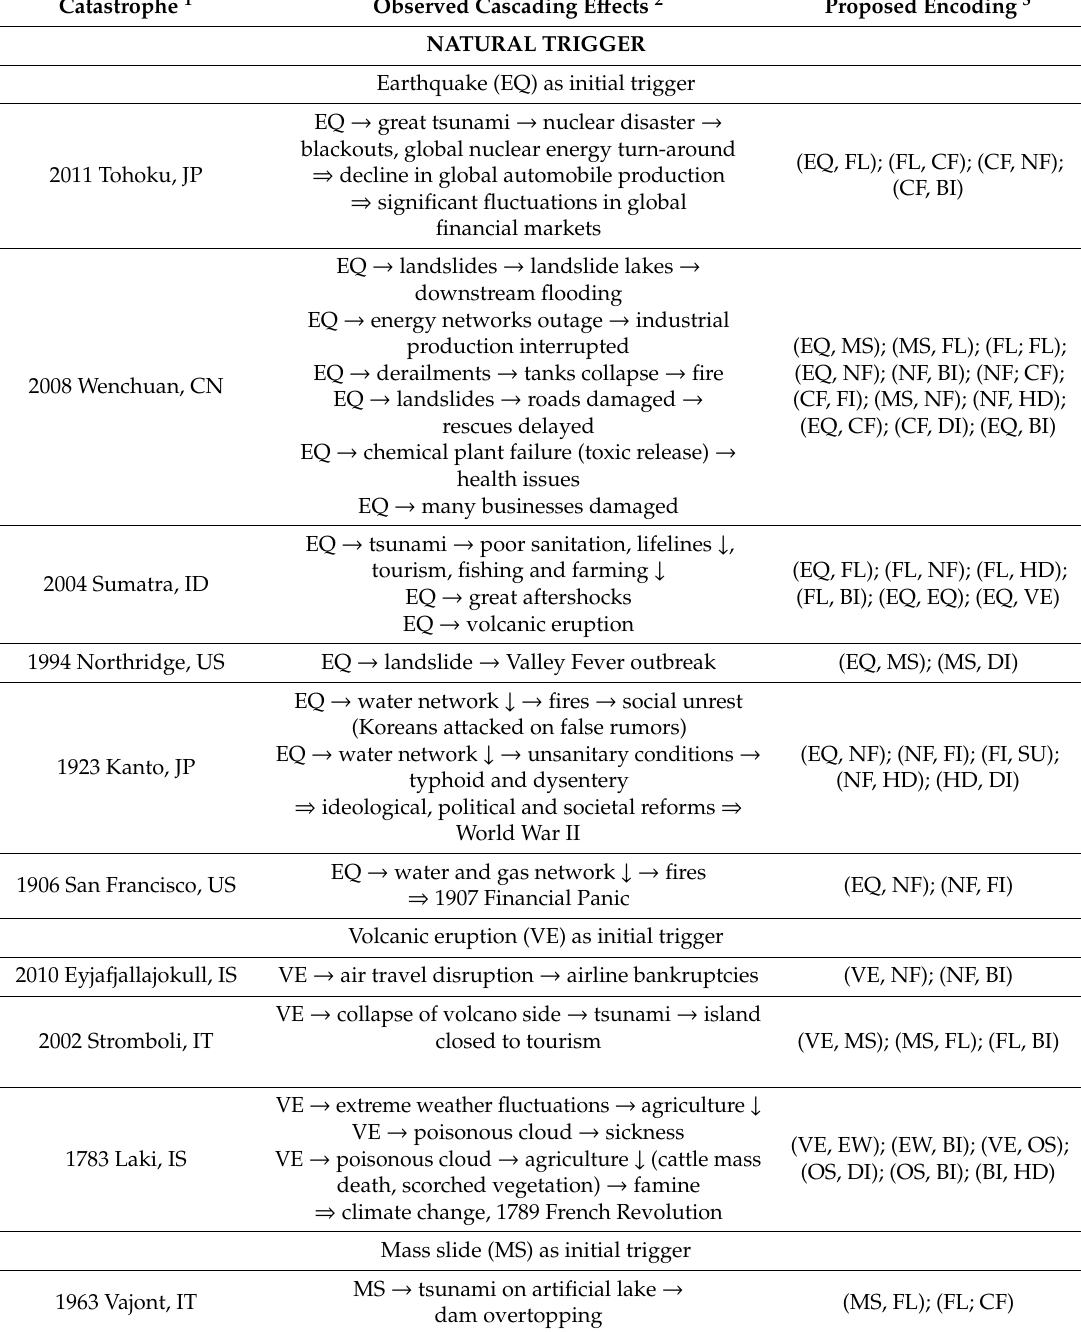
Table 2. List of infamous catastrophes with rich and / or peculiar